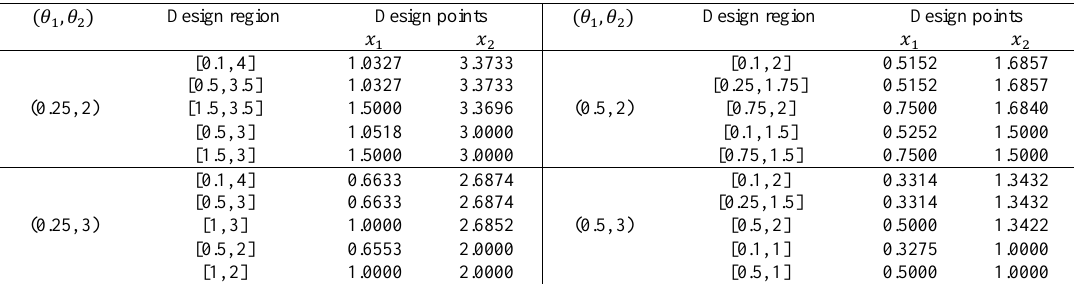
𝑤 = 0.35, 𝑤 = 0.65 1 2